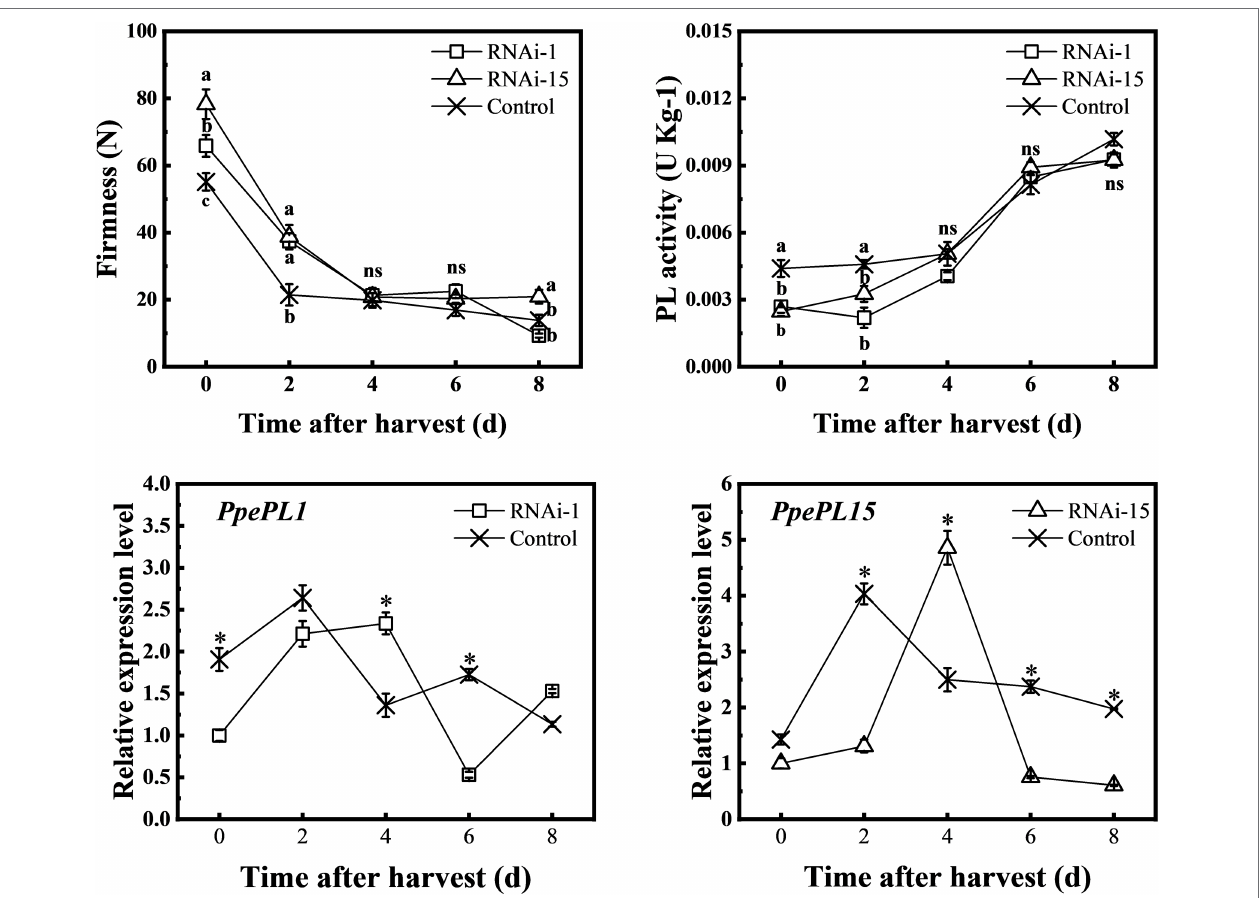
FIGURE 7 | Changes in the firmness, PL activity, and relative expression of PpePL1 and PpePL15 during storage of control (TRV2), RNAi-1 (TRV- PpePL1 ), and RNAi-15 (TRV- PpePL15 ). Expression levels determined by RT-qPCR are relative to the expression in control (TRV2) fruit at the start of the storage period. RT-qPCR data were normalized by PpTua5 and PpCYP2 . Each values represents the means ± standard error of three replicates. The asterisk indicated a significant difference ( p < 0.05), using the two-tailed Student’s t -test. Significant differences ( p < 0.05) between means are indicated by different letters ( a , b , and c